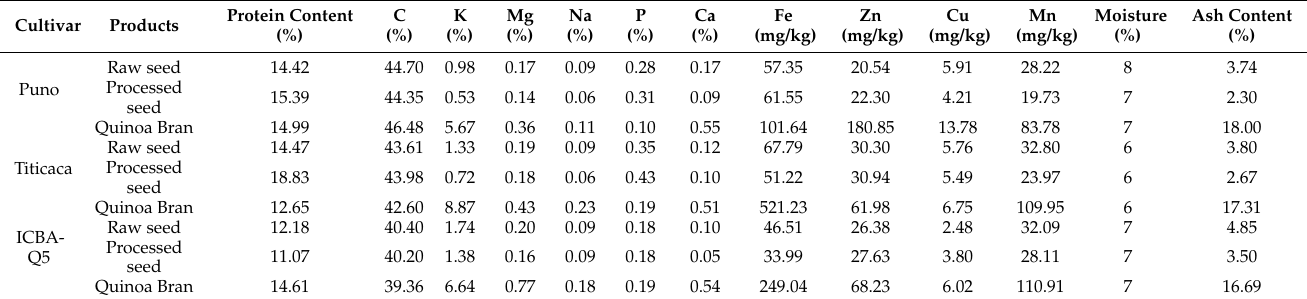
Table 3. Nutrients content of raw, processed seeds and quinoa bran for Puno, Titicaca and ICBA-Q5 cultivars.